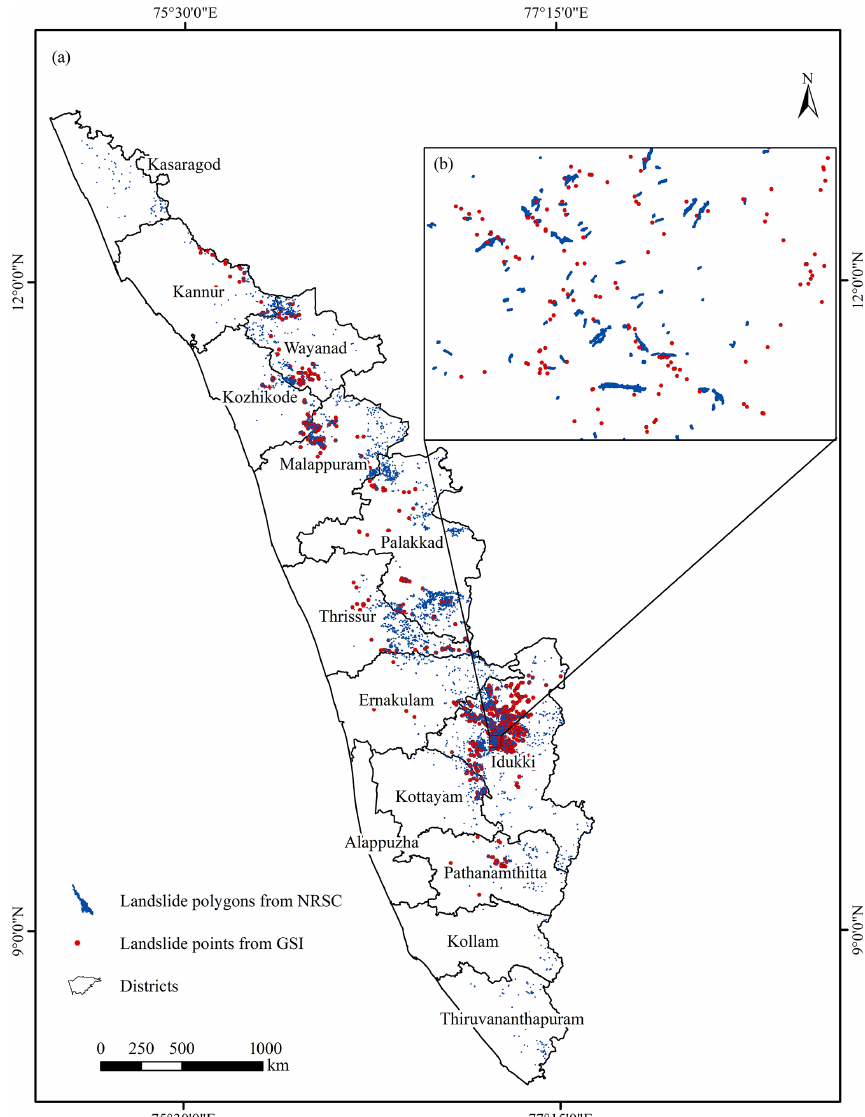
Figure 2. Overview map of the existing